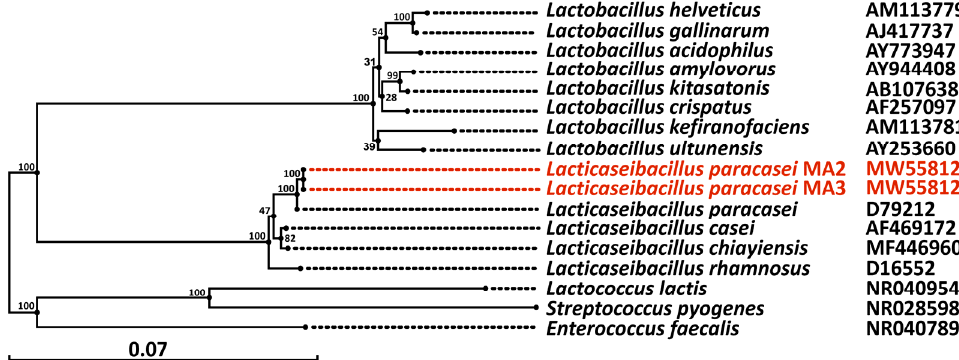
Figure 1. Phylogenetic tree constructed using 16S rRNA sequences of various Lactobacillus species type strains [14] and 16S rRNA sequences of strains isolated from mahewu in this work (marked in red). The evolutionary distance corresponding to one change every 100 nucleotides is shown by the scale. The number over the nodes corresponds to their bootstrap values.